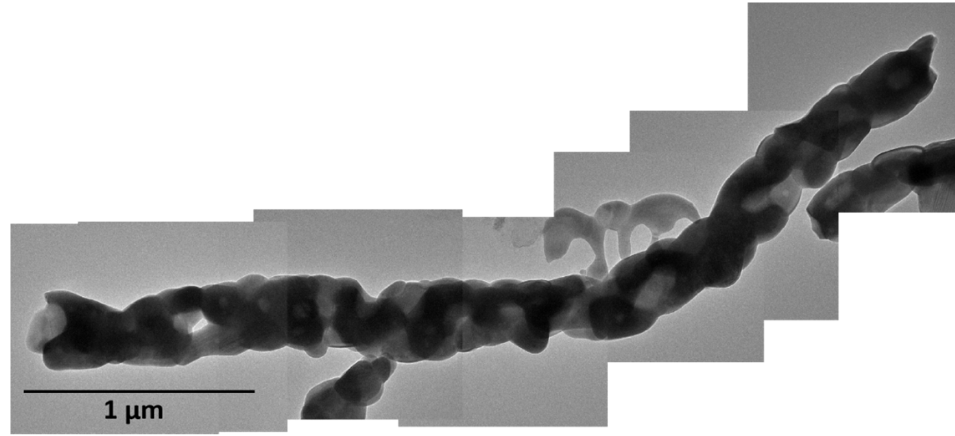
Figure 4. FESEM image of Cu 2 Y 2 O 5 nanofibers with different magnification ( a ) x10.0 k and ( b ) x50.0 k .